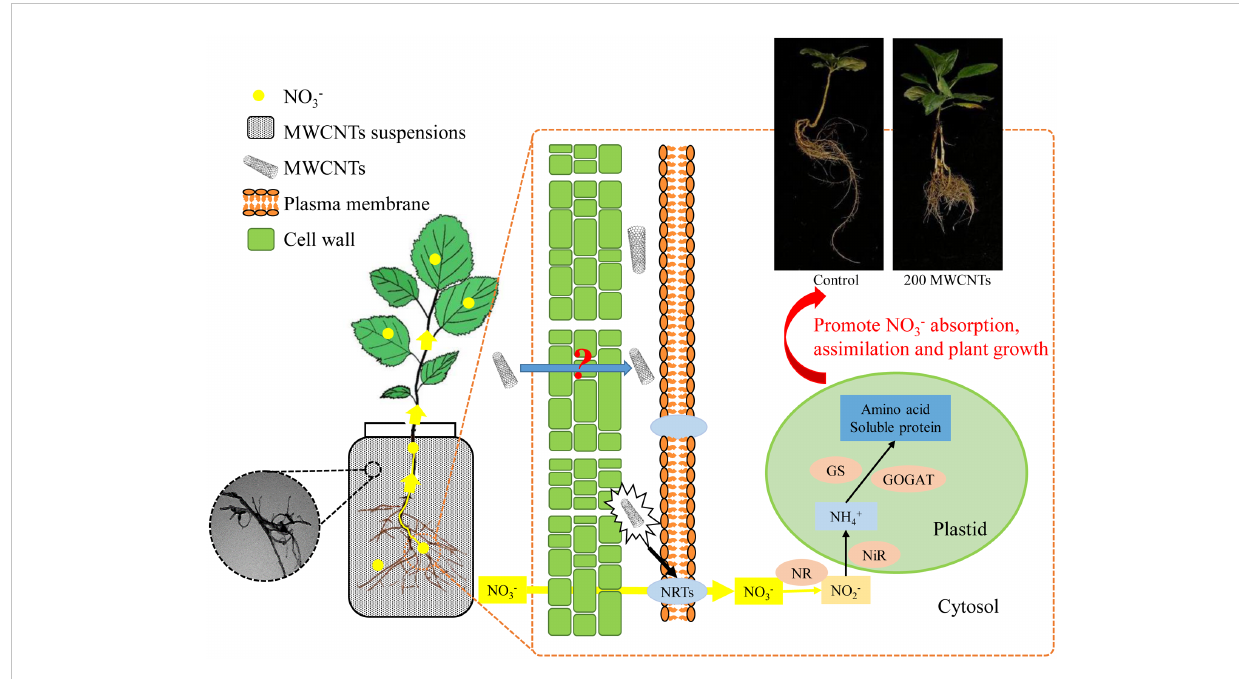
FIGURE 8 Mechanisms of MWCNTs promoting nitrate uptake and assimilation in roots of Malus hupehensis